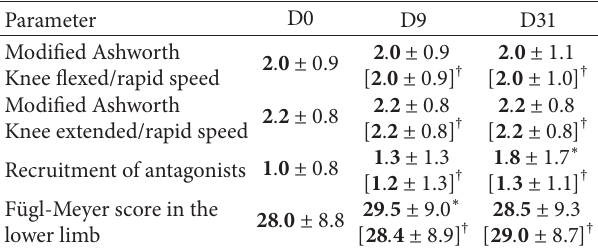
Figure 2: Anterior (a) and posterior (b) views of optoelectronic markers and positioning of electrodes (c) on the 3 heads of triceps surae for recording of electromyographic responses 𝑀 , 𝐻 , and 𝑇 . (1) Anterior superior iliac spine; (2) thigh marker; (3) lateral femoral condyle; (4) leg marker; (5) lateral malleolus; (6) head of second metatarsus; (7) posterior superior iliac spine; (8) calcaneus. G: medial gastrocnemius; GL: lateral gastrocnemius; SO: soleus. Table 1: Course of clinical parameters (mean ± standard deviation) during the 1Hz and 10Hz ( † brackets) stimulation protocols: before (D 0 ) and after (D 9 : early assessment; D 31 : late